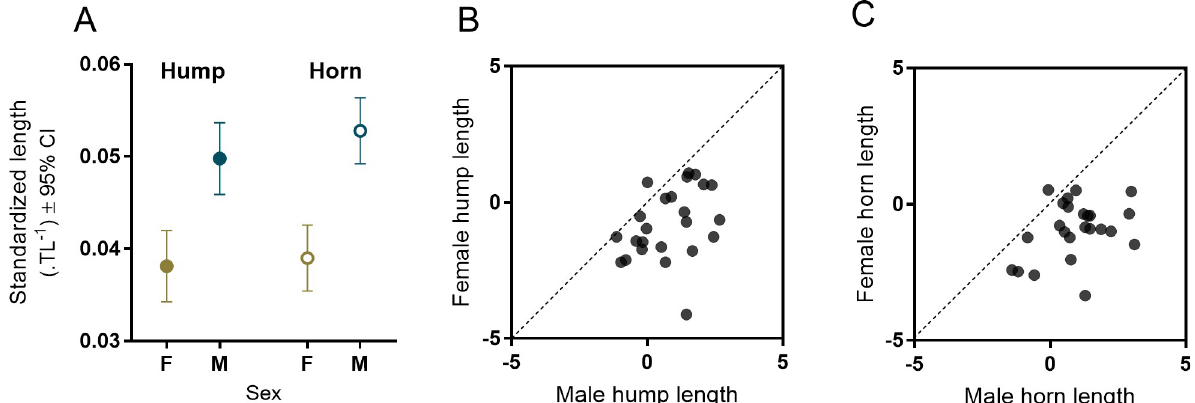
Fig 5. Sex differences in the relationships between total length and (A) hump length, and (B) horn length of 76 Heniochus varius individuals sampled in Kimbe Bay, Papua New Guinea. Females are gold and males are dark blue.